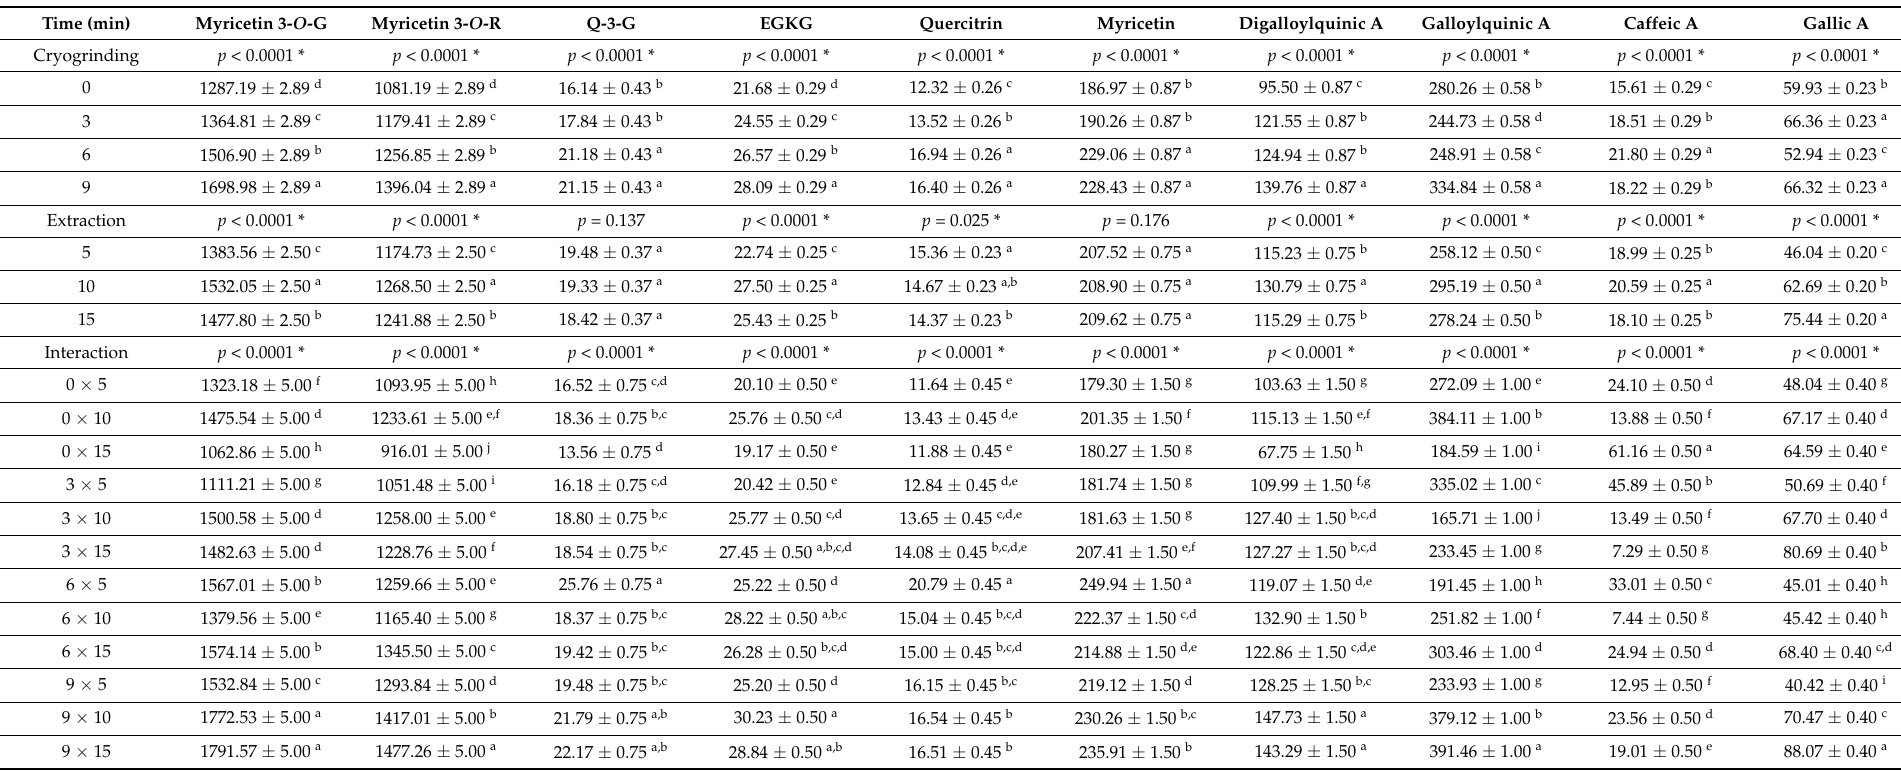
Table 2. Phenolic profile (mg/100 g dw) of myrtle leaf extract obtained by different cryogrinding and extraction